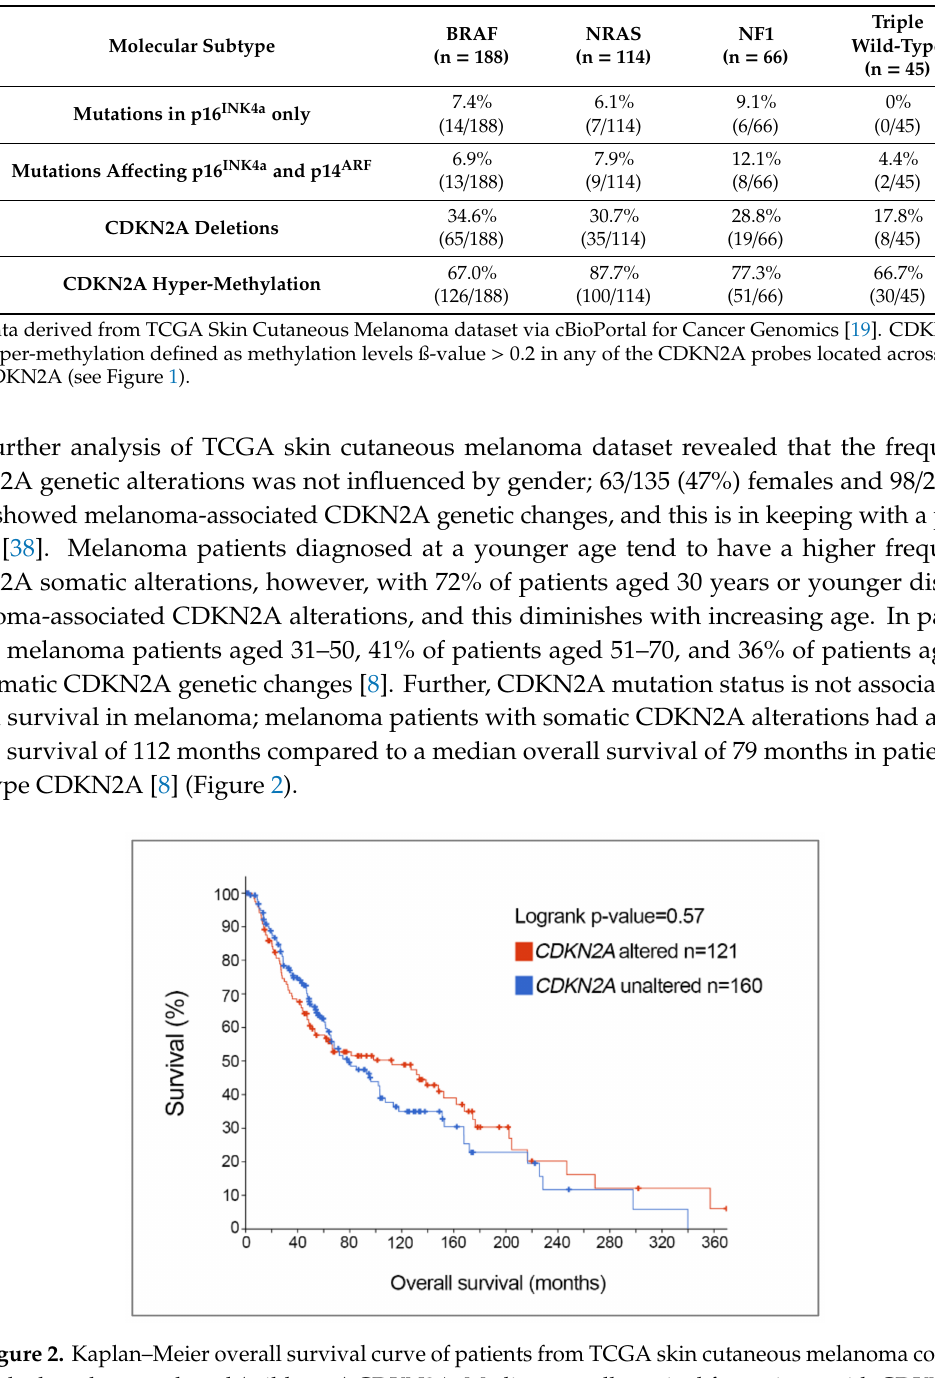
Figure 2. Kaplan–Meier overall survival curve of patients from TCGA skin cutaneous melanoma cohort with altered vs. unaltered (wild-type) CDKN2A. Median overall survival for patients with CDKN2A alterations is 112 months, compared to a median overall survival of 79 months for melanoma patients with unaltered CDKN2A ( p = 0.57, logrank